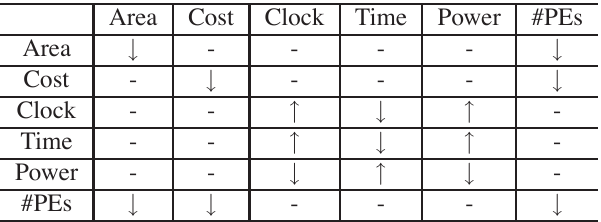
Table 1. Concurrent and Collaborative